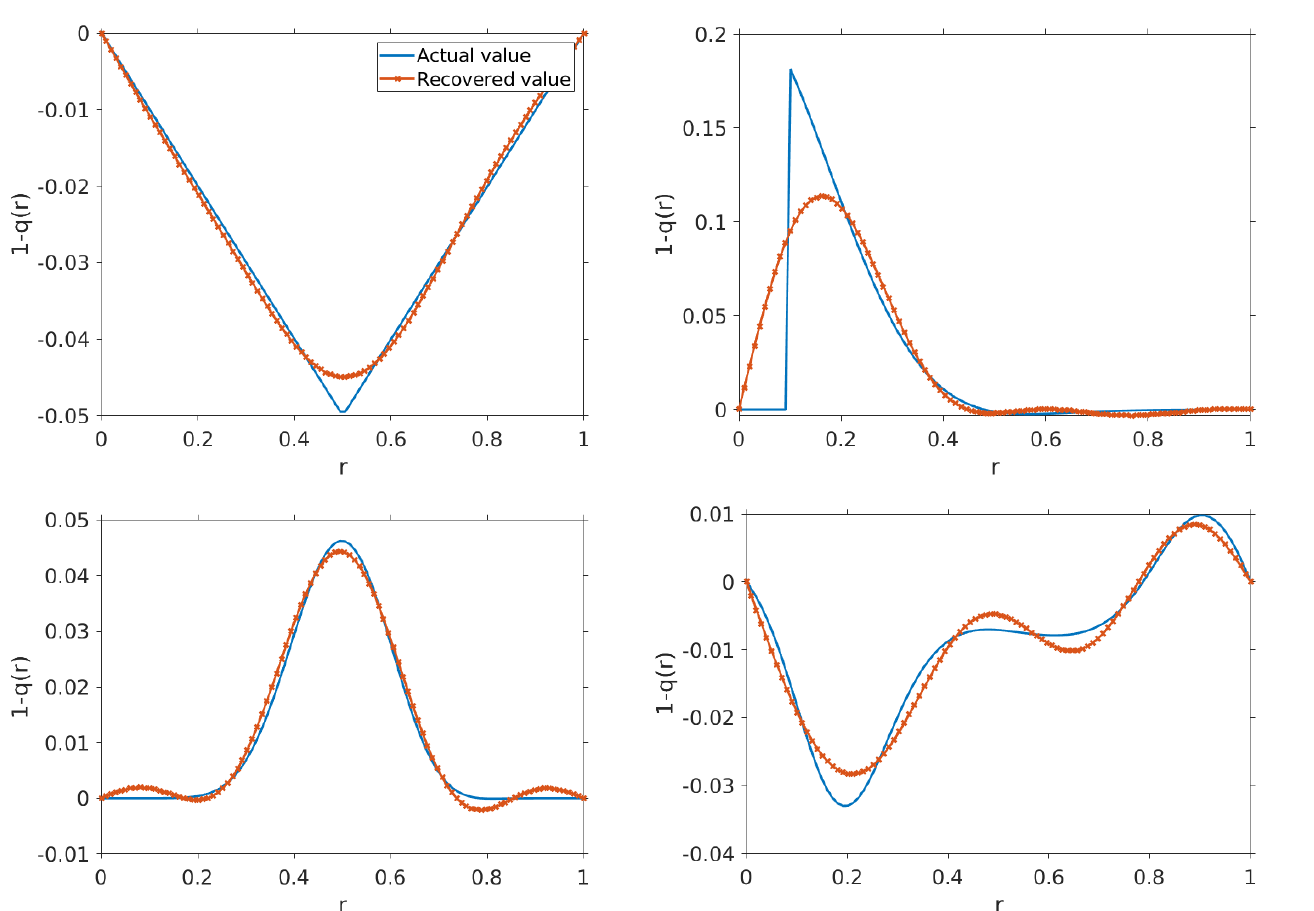
Figure 3. General indexes of refraction and those reconstructed by the trained model for X 5 with k = 7. The relative errors (cid:107) P − ˆ q (cid:107) (cid:107) P (cid:107) 5 q 2 / 5 q 2 are 0.0365 ( top left ), 0.0164 ( top right ), 0.0267 ( bottom left ), and 0.0574 ( bottom right